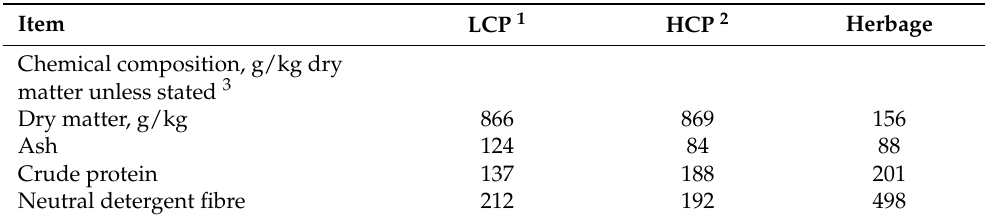
Table 2. Chemical composition, ingredient inclusion level and metabolisable protein content of experimental